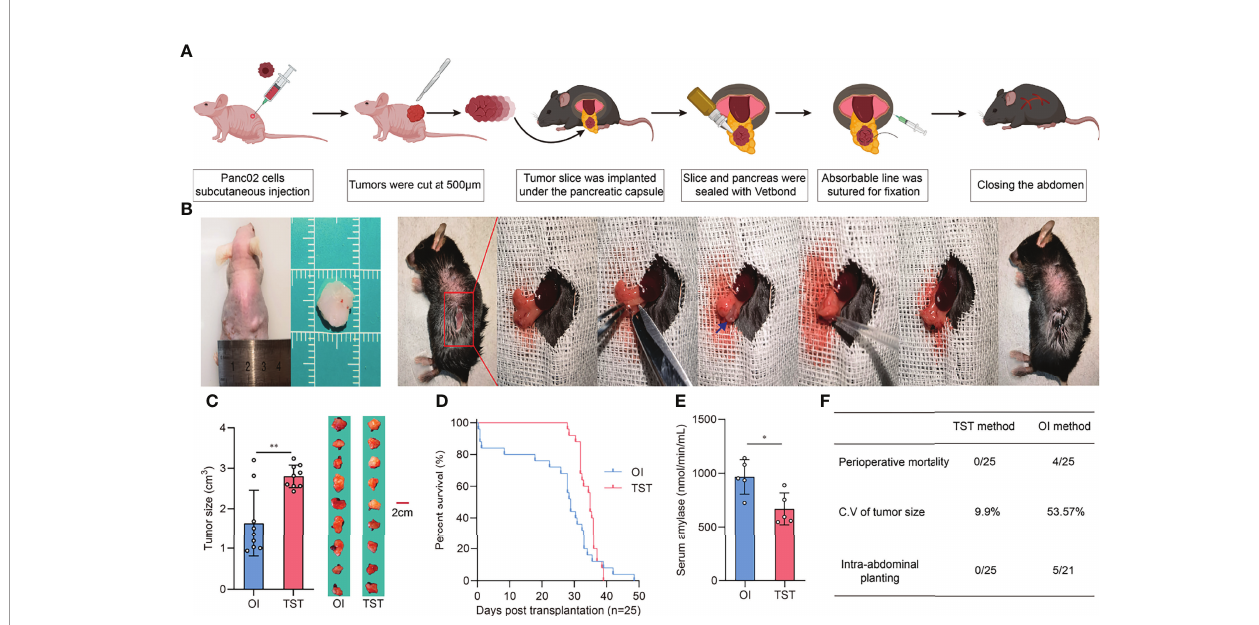
FIGURE 1 | Development and evaluation of the TST mice model. (A) Schematic outline of operation procedure. (B) Tissue slices of subcutaneous tumor in nude mice (Left). Representative images of the TST mice model construction process (Right). The blue arrow indicates tumor tissue slices. (C) Tumor sizes of OI and TST mice models at 21 days post-inoculation (n=9 each, **P<0.01). (D) Survival of OI and TST mice models (n=25 each). (E) Serum amylase levels of OI and TST mice models at 12 hours post-inoculation (n=5 each, *P<0.05). (F) Comparison of necropsy results between OI and TST mice